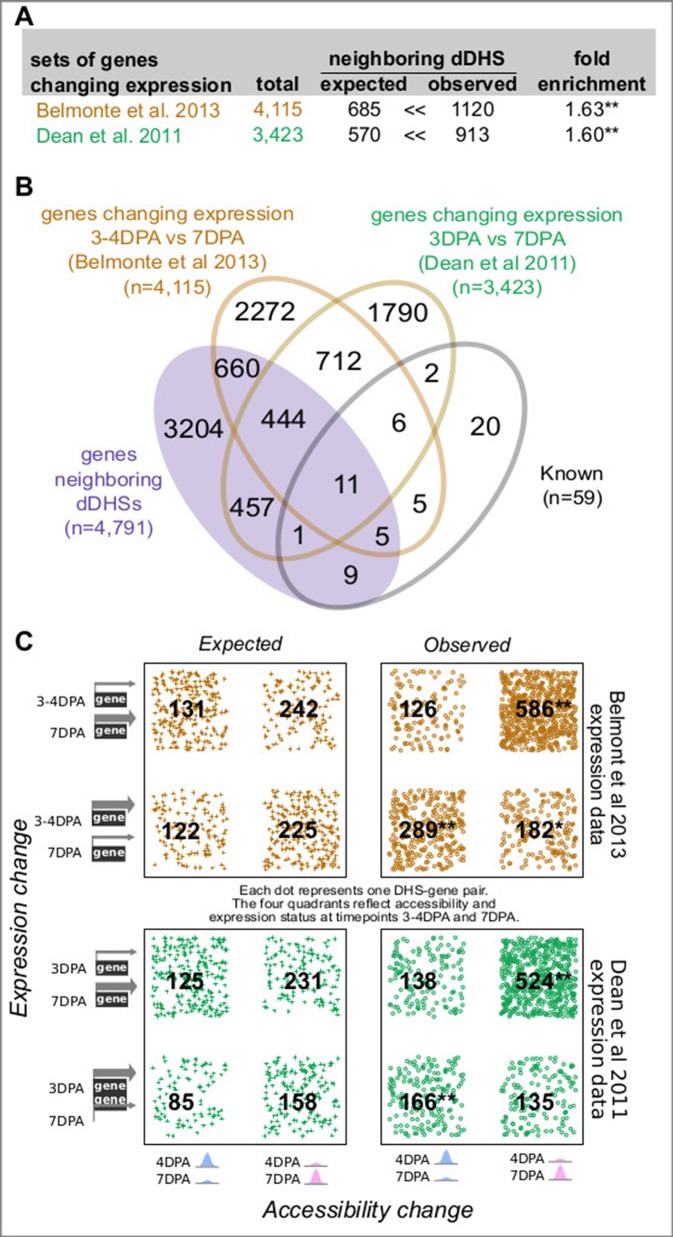
Genes neighboring developmentally dynamic DNase I-hypersensitive sites (dDHSs) are often differentially expressed. (A) Overlap between the set of genes neighboring dDHSs and genes found to be differentially expressed in seed coat at stages 4 and 7 DPA in two different data sets (Dean et al., 2011; Belmonte et al., 2013). (B) Overlap of all four sets of genes. (C) Genes that are more highly expressed tend to be near more accessible DHSs and vice versa. P-values are calculated using the hypergeometric test. One asterisk (*) indicates p-value 0.01. Two asterisks (**) indicate p-value 10-20.